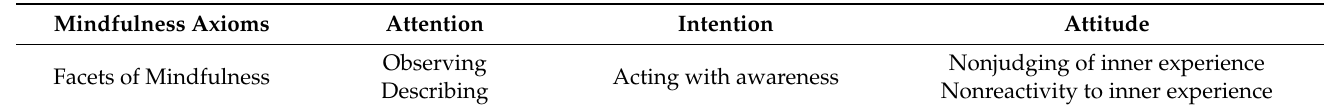
Table 1. Connection of the Five Facets of Mindfulness to the Model of Mindfulness Axioms. Mindfulness Axioms Attention Intention Attitude Observing Nonjudging of inner experience Facets of Mindfulness Acting with awareness Describing Nonreactivity to inner